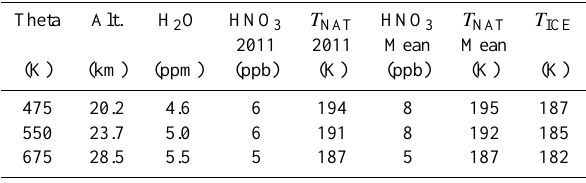
Table 2. Threshold temperature of NAT and ICE formation calcu- Figure 5. Top: ECMWF ERA-Interim minimum temperature north of 60°N at 475 K (red), 550 lated for March 2011 and Arctic mean from monthly average HNO 3 K (blue) and 675 K (green) and NAT (solid lines) and ICE (dotted) threshold temperatures at the and H 2 O concentrations reported by MIPAS (Arnone et al., 2012).